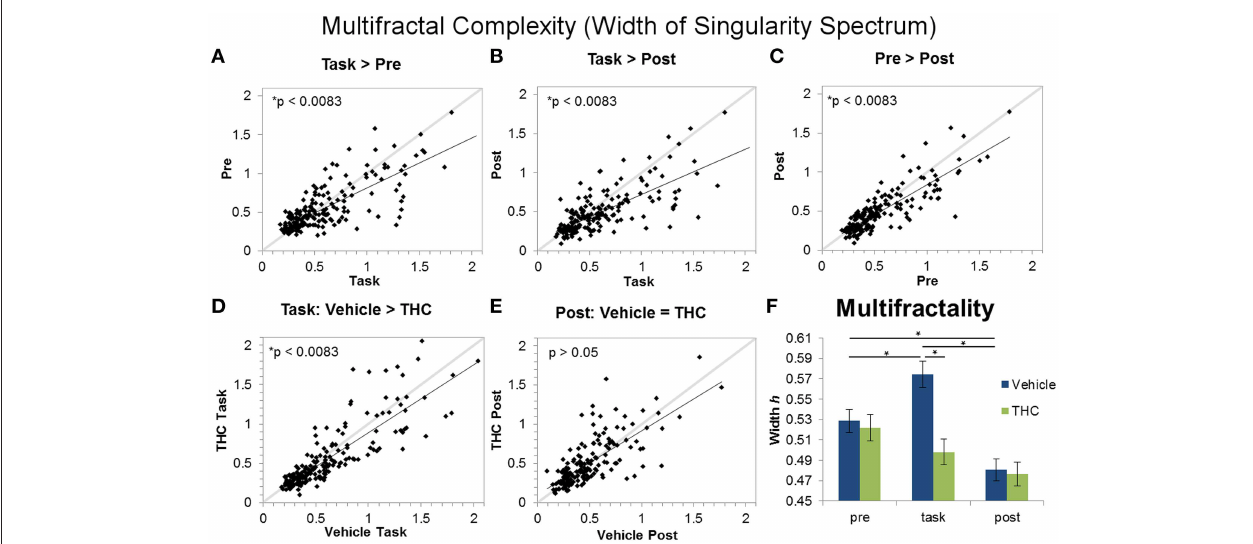
FIGURE 7 | Multifractality (singularity spectrum width) across task and rest conditions after vehicle or THC administration. The scatter plots show each data point obtained by averaging singularity spectrum width for individual neurons over all recordings. All neurons included in the analysis were recorded for 2–8 days of vehicle and THC administration. Thick gray lines are y = x and thin black lines are regression lines. Data points from vehicle only sessions are displayed in (A–C) . (A) Neurons exhibit greater multifractal complexity (defined by the width or the singularity spectrum) during the DNMS task compared to pre-task recordings. (B) Multifractal complexity of ISIs is greater during the task compared to post-task recordings. (C) On average, multifractal complexity is greater during the pre-task resting state recording compared to the post-task recordings. (D) THC significantly reduces multifractal complexity during the DNMS task. (E) THC has no effect on multifractal complexity during the post-task recordings. (F) Each bar was obtained by averaging multifractality (width h) from individual spike trains within specified recording phase and drug treatment combinations ( n = 771 –1004 neurons per group). Errors bars represent S.E.M. Statistical significance is designated by * indicating p < 0 . 0083